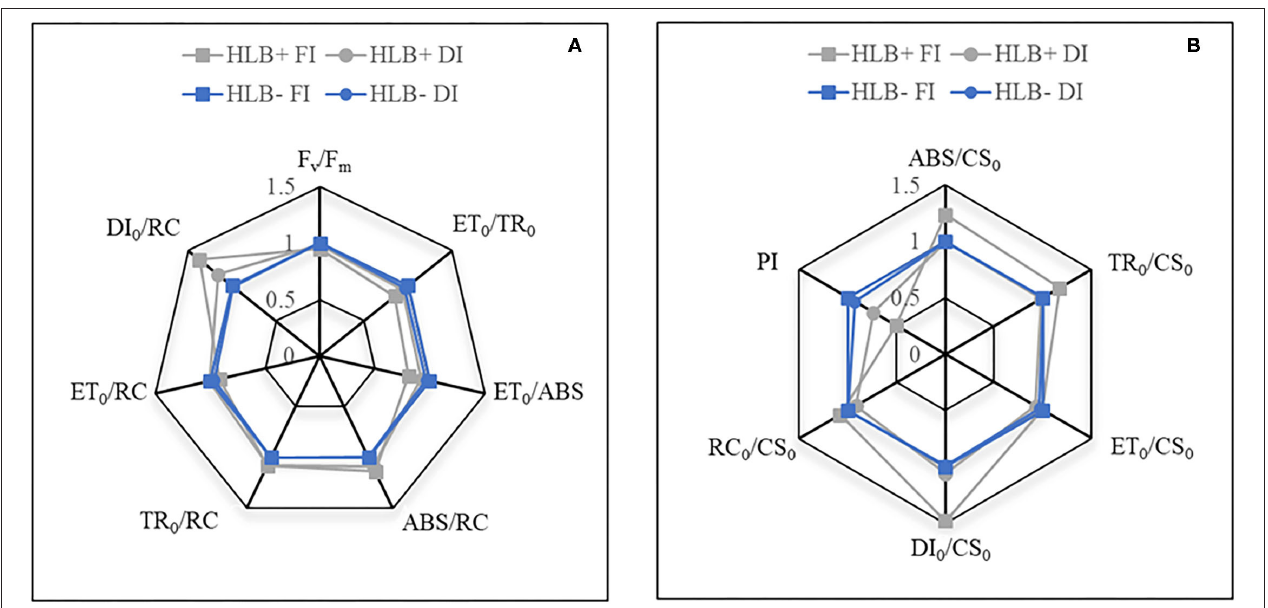
FIGURE 5 | (A,B) Relative changes in chlorophyll a fluorescence traits of leaves of “Valência” orange trees [ Citrus sinensis (L.) Osbeck] grafted on citrumelo “Swingle” rootstock [ Citrus paradisi Macfad. x Poncirus trifoliata (L.) Raf.] either infected with “ Ca . Liberibacter asiaticus” ( + ) or healthy (–) and exposed to two water management treatments: fully irrigated (FI) and deficit-irrigated (DI). ABS/CS 0 , number of photons absorbed by an excited PSII cross-section; ABS/RC, effective antenna size of an active reaction center; DI 0 /CS 0 , energy dissipation rates per cross-section; DI 0 /RC, effective dissipation of an active reaction center; ET 0 /ABS, quantum yield of electron transport; ET 0 /CS 0 , electron transport in a PSII cross-section; ET 0 /RC, electron transport in an active reaction center; ET 0 /TR 0 , electron transport probability; Fv/Fm, maximum quantum yield of primary photochemistry; PI: photosynthetic index; RC/CS 0 , fraction of active reaction centers per excited cross-section of leaf; TR 0 /CS 0 , maximal trapping rate in a PSII cross-section; TR 0 /RC, maximal trapping rate of